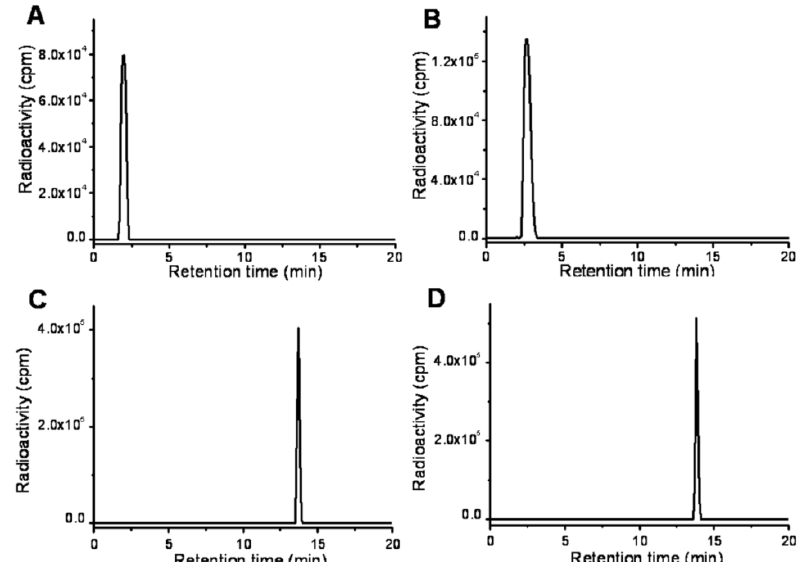
Figure 2. Quality control analysis of labeling mixture. Radioactivity signals